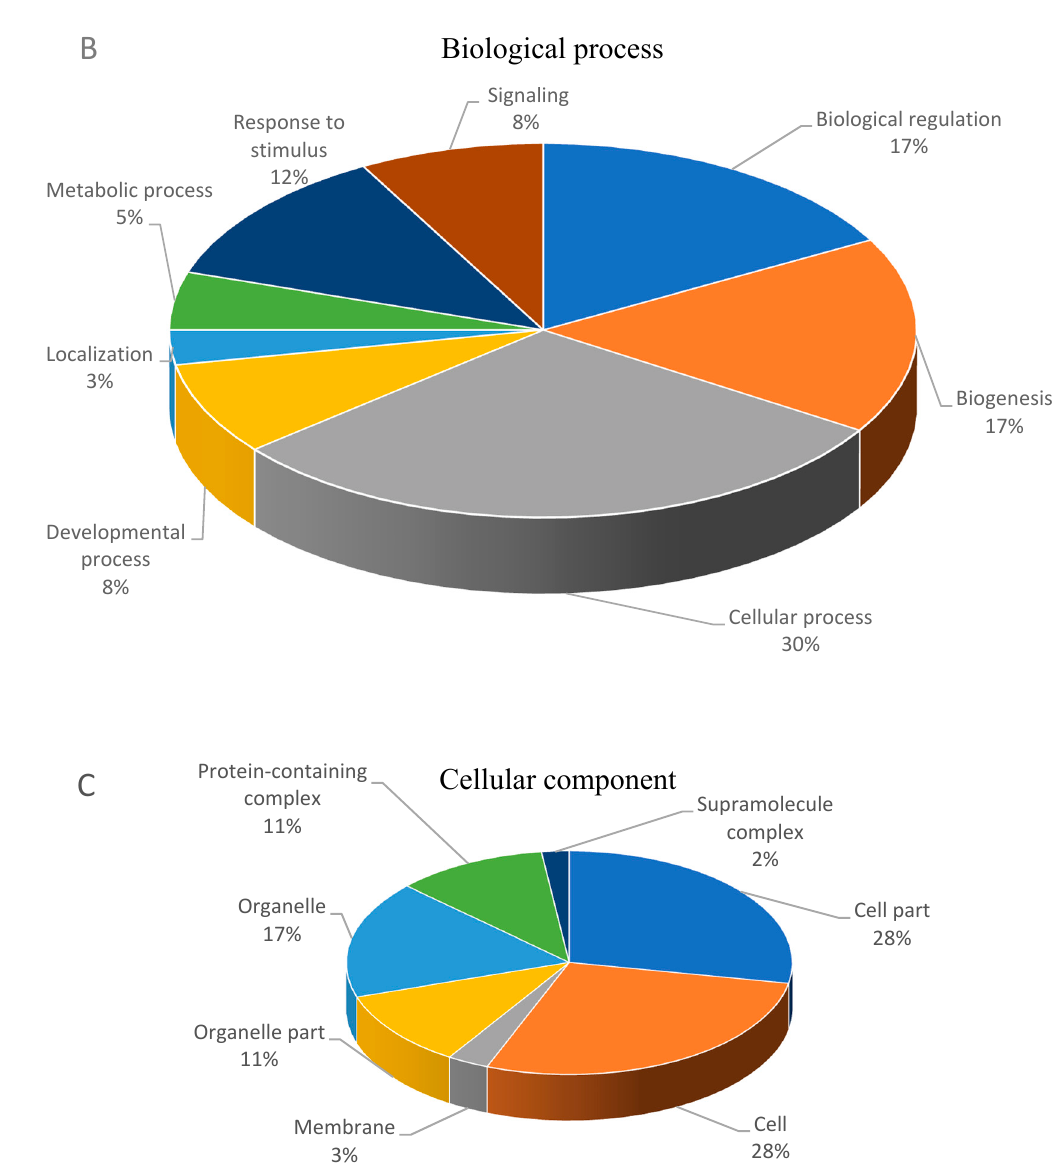
Figure 3. Functional classification of decreased abundance proteins according to their molecular function ( A ), biological process ( B ) and cellular component ( C ).